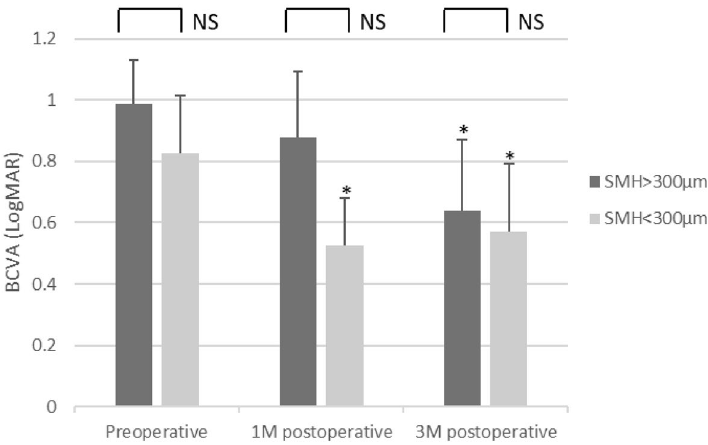
Figure 2. Comparison of postoperative BCVA classified by preoperative SMH height (μm). *P < 0.05.